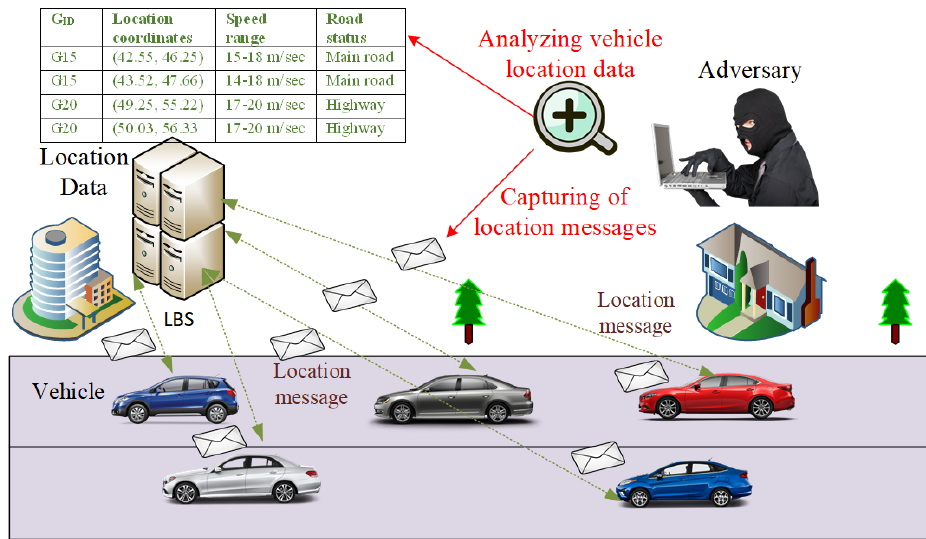
Figure 9. Adversary analyzing vehicle location data.